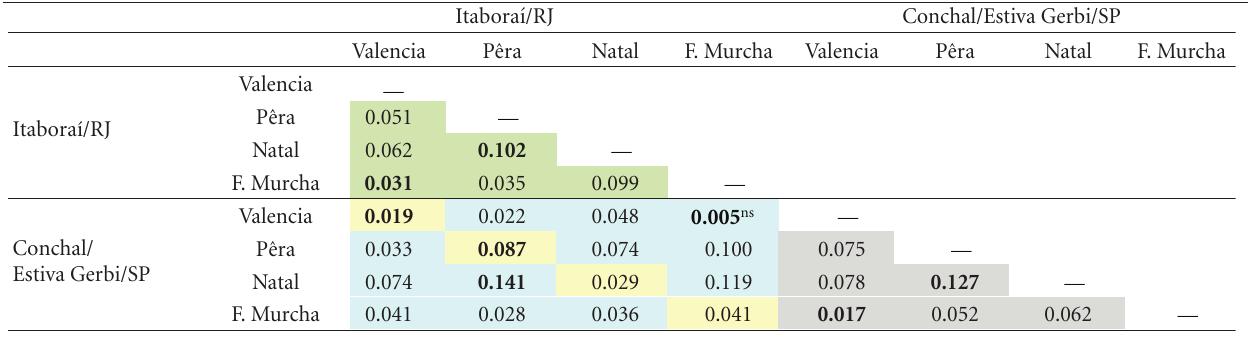
Table 5: Indices of genetic di ff erentiation F SC showed by the groups of isolates when comparing each one with the others according to varieties and geographic